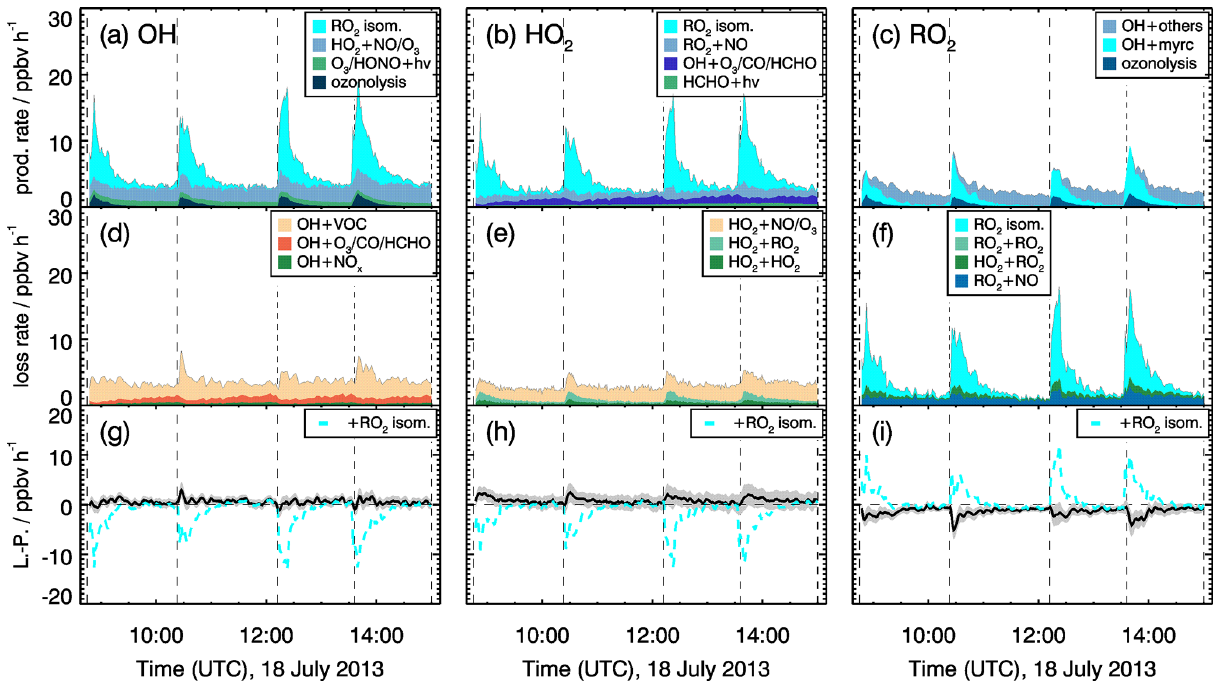
Figure 12. Rates of radical production and destruction reactions for OH, HO 2 and RO 2 for experiments at low NO mixing ratio ( < 0 . 11ppbv) on 18 July 2013. Grey areas in the lower panels give the uncertainty of L − P . In the bottom row, the black and cyan lines denote the radical budget with and without considering MyO 2 isomerization reactions. Upper limits for yields of OH and HO 2 radicals from MyO 2 isomerization reactions of one are assumed in the calculations of their production